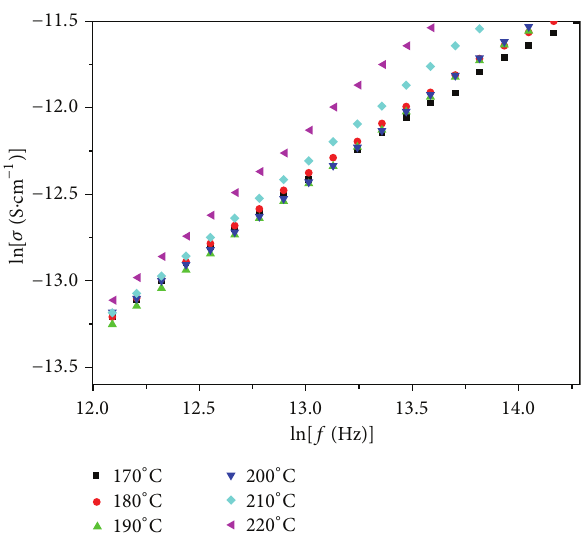
Figure 8: ln (𝜎) versus ln (𝑓) for amino-p-anisidine-PVC (P 2 ). HCl and HI groups as shown in the TG analysis described